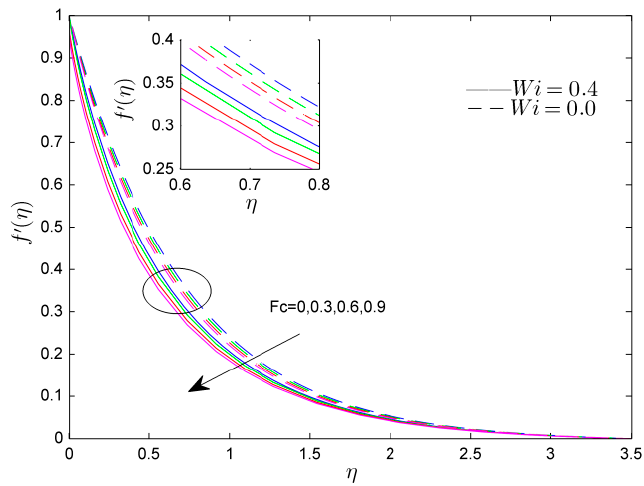
Figure 5. Effect of Forchheimer number (𝐹𝑐) on 𝑓 (cid:4593) (𝜂) .